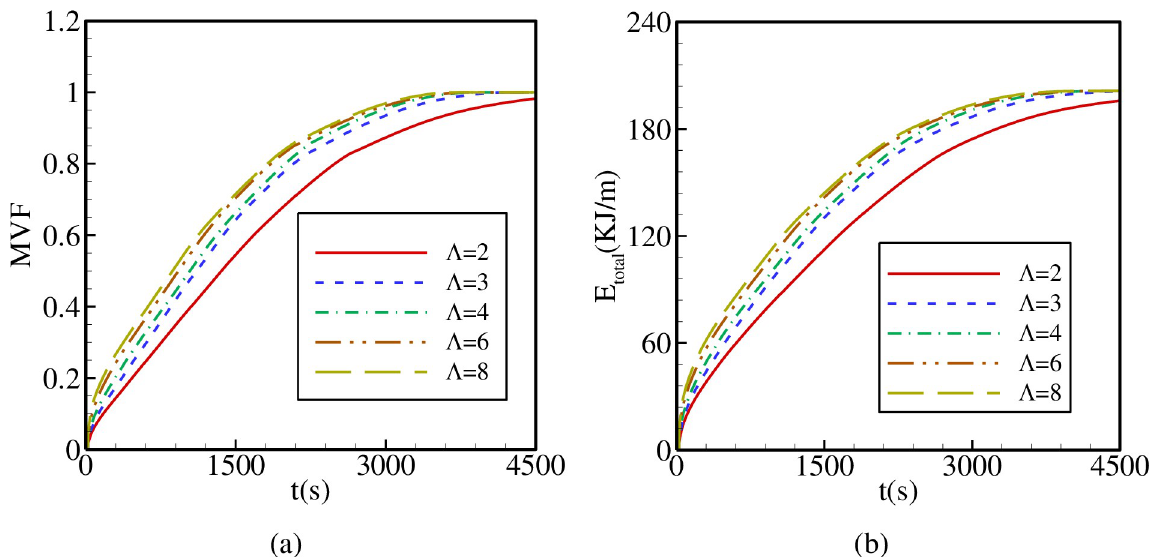
Fig 9. The effects of the number of petals of the quasi-petal heat pipe on (a): the melt volume fraction (MVF); (b): the total energy stored (E total ) when r d = 0.6 r s , A = 0.15 r s , and η = π /4.